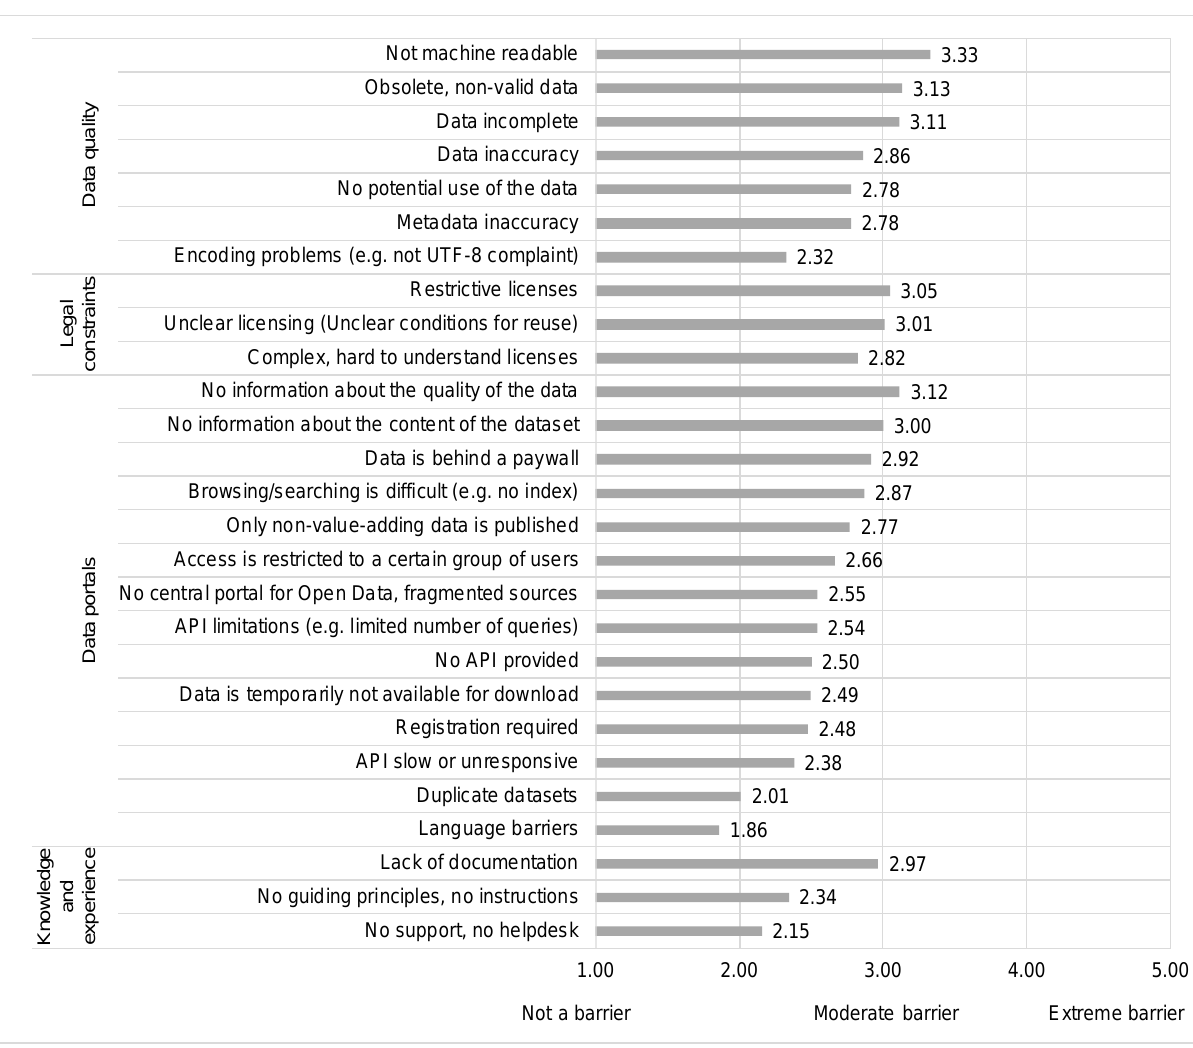
Figure 5: Barriers to Using Open Data (Source: